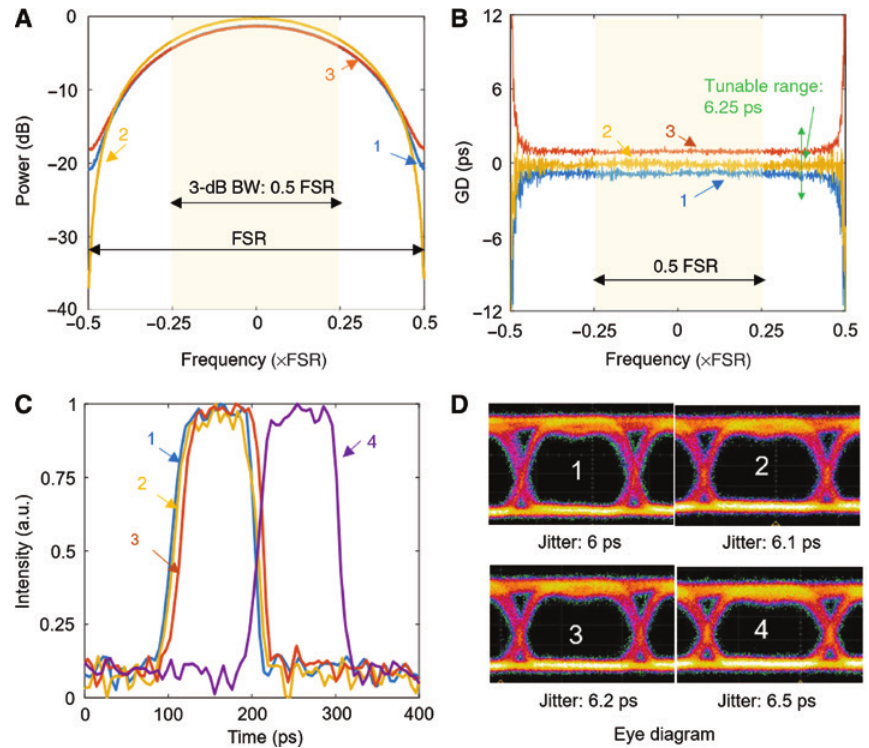
Figure 10: (A) Frequency responses and (B) group delays of the programmable filter when tuning the coupling ratio, ҡ of the A-MZI. (C) Impulse responses of the filter when the input is 100-ps pulse for different coupling ratio cases and their corresponding OOK eye diagram of